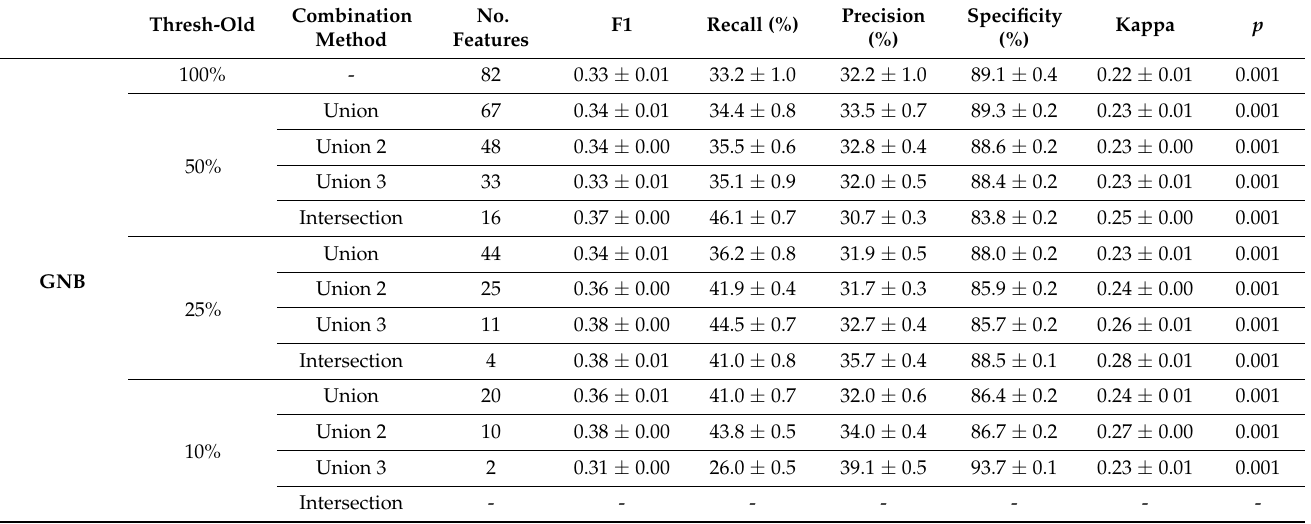
Table A6. Performance of the four classification models on detection fall using GAITRite System dual task walking data set ; Gaussian Naive Bayes (GNB); Decision Tree (DT); k-Nearest Neighbor (kNN); Support Vector Machine (SVM); p -value via permutation